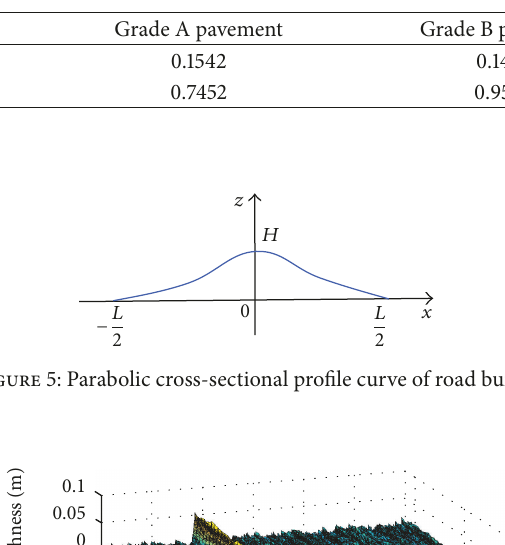
Table 2: Regression analysis of standard grade road.